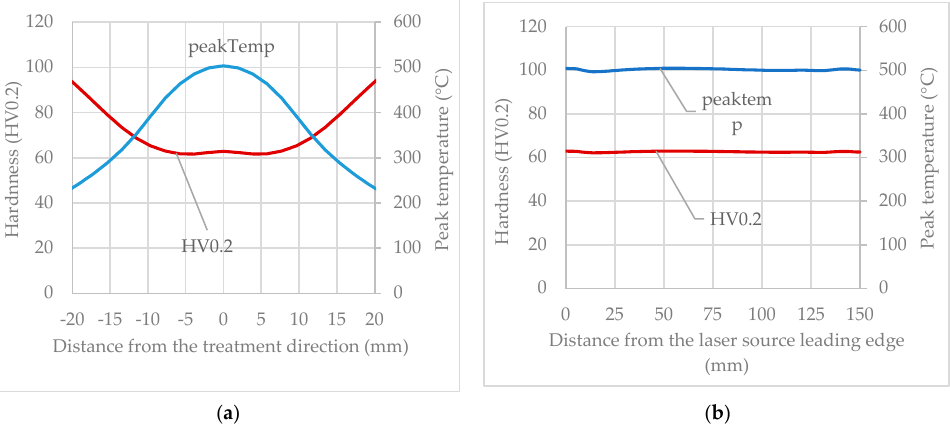
Figure 33. ( a ) Hardness and peak temperature profiles evaluated transversely to the treatment direction (T500V5-APS); ( b ) Hardness and peak temperature profiles evaluated along the treatment direction (T500V5-APS).